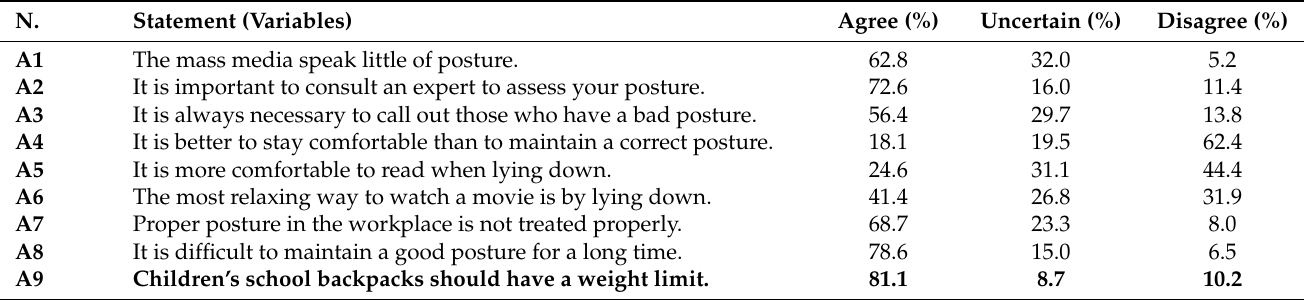
Table 3. Attitude of respondents toward the